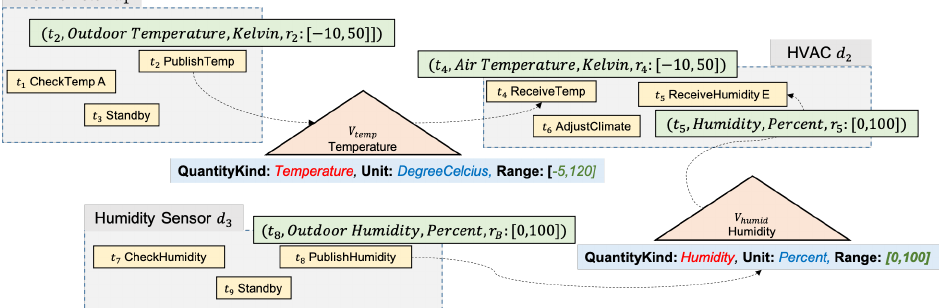
Figure 9. Service Design S HVAC for an HVAC system of a smart farm.